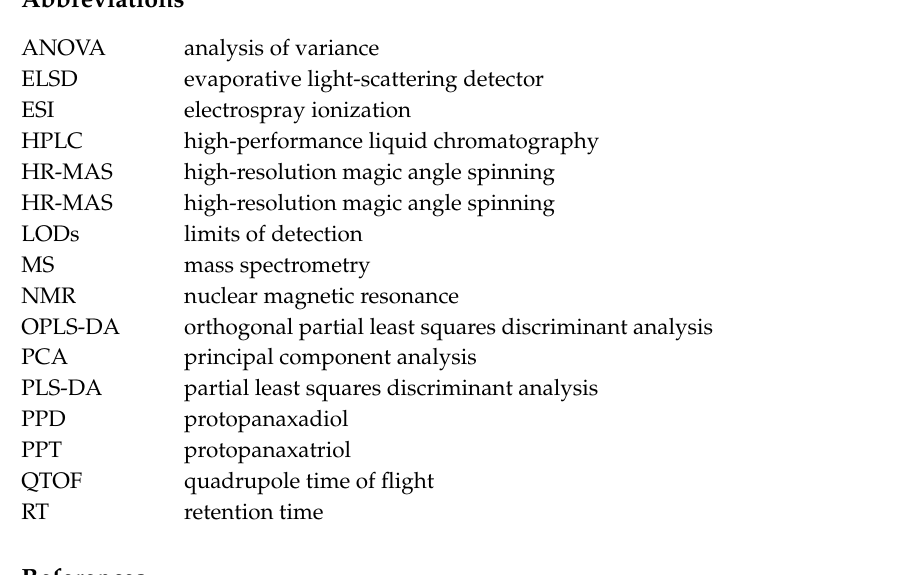
Figure S1: Representative 1 H-NMR spectra of representative cultivars in each variant, Figure S2: Representative 1 H-NMR spectra of cultivars in the violet-stem variant, Figure S3: Box plots of quantified primary metabolites, Figure S4: Box plots of quantified